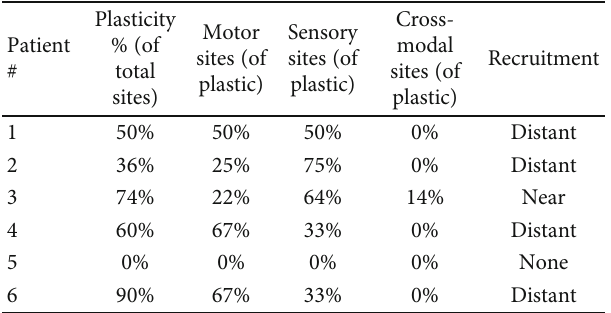
Table 3: Mechanisms and sensorimotor representation of plasticity. We categorized the stimulation sites into plastic or nonplastic. Overall, 63% of sites were plastic, with motor and sensory plasticity distributed as shown. The cross-modal plasticity seen was a motor-to-sensory change. Based on the observed mechanism of plasticity, either distant or near recruitment was